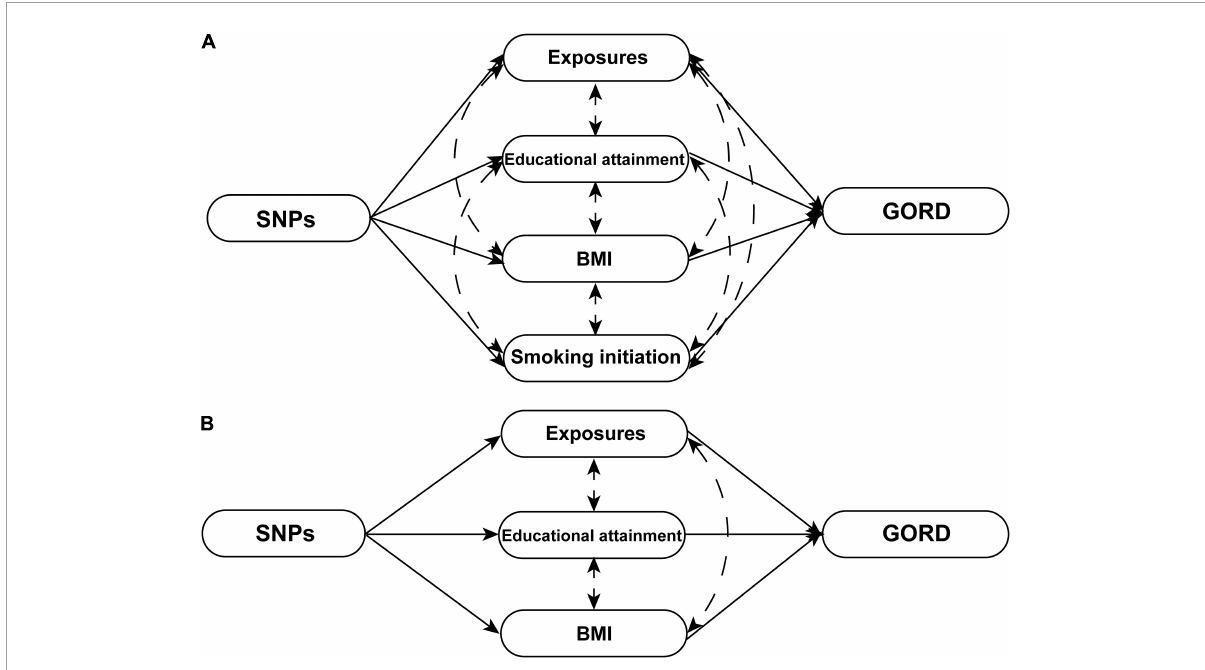
FIGURE2 The schematics of MVMR analyses. (A) The schematic of MVMR analyses with adjustment of educational attainment, smoking initiation, and BMI for 11 significant causal exposures [cigarette consumption, insomnia, short sleep, leisure sedentary behavior (TV watching), waist-to-hip ratio, height (standing and sitting), major depressive disorder, anxious feeling, life satisfaction, and positive affect]. (B) The schematic of MVMR analyses with adjustment of educational attainment and BMI for four significant causal exposures [leisure sedentary behavior (computer use), hand grip strength (left and right), and birth weight]. Exposures that respectively strongly genetically correlated with the BMI (body fat percentage, whole body fat mass, visceral adipose tissue, and waist circumference), smoking initiation (lifetime smoking), and educational attainment (income and intelligence) were excluded from MVMR